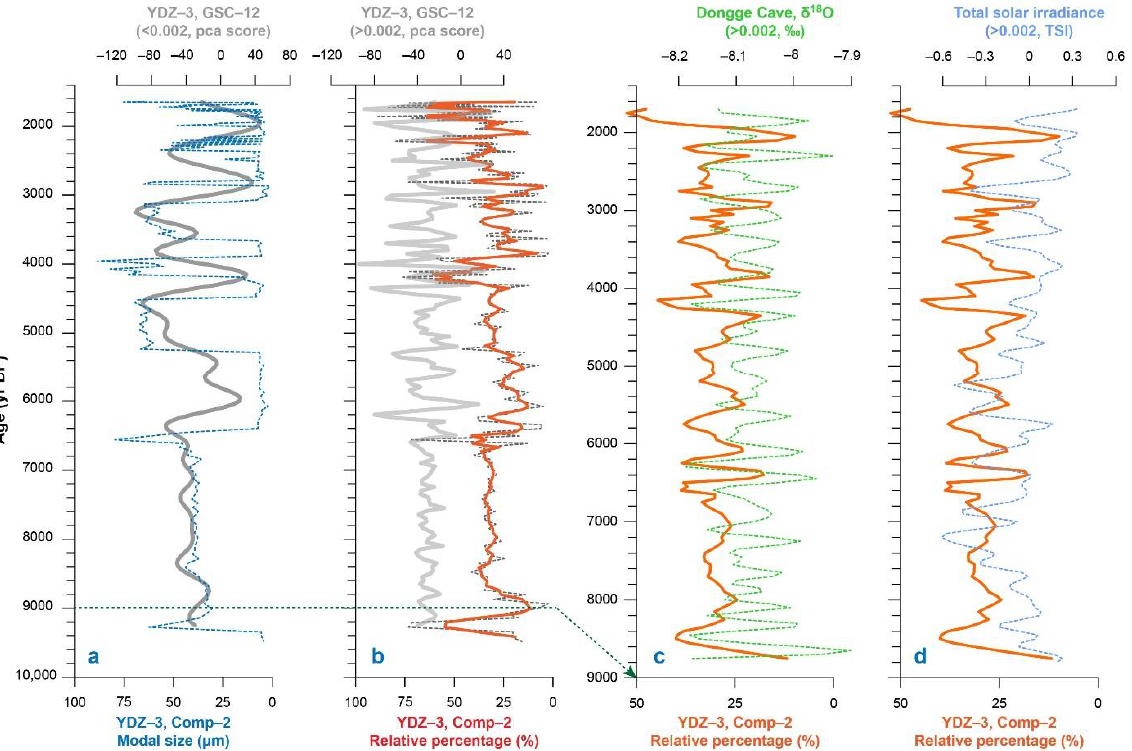
Figure 6. Correlating YDZ–3 record to various paleoenvironmental proxies on centennial timescales. ( a ) YDZ–3 Comp–2 modal size with the low-frequency (<0.002) component of GSC–12 record [8]; ( b ) YDZ–3 Comp–2 relative percentage (original value, dashed line; 3–point moving average, solid line) with the high-frequency (>0.002) component of GSC–12 record [8]; ( c ) Comparison between YDZ–3 Comp–2 relative percentage and the high-frequency (>0.002) component of Dongge Cave δ 18 O record [50]; ( d ) Comparison between YDZ–3 Comp–2 relative percentage and the high-frequency (>0.002) component of total solar irradiance (TSI) during the Holocene [51]. Noted that data in ( c , d ) are 3–point moving average records.